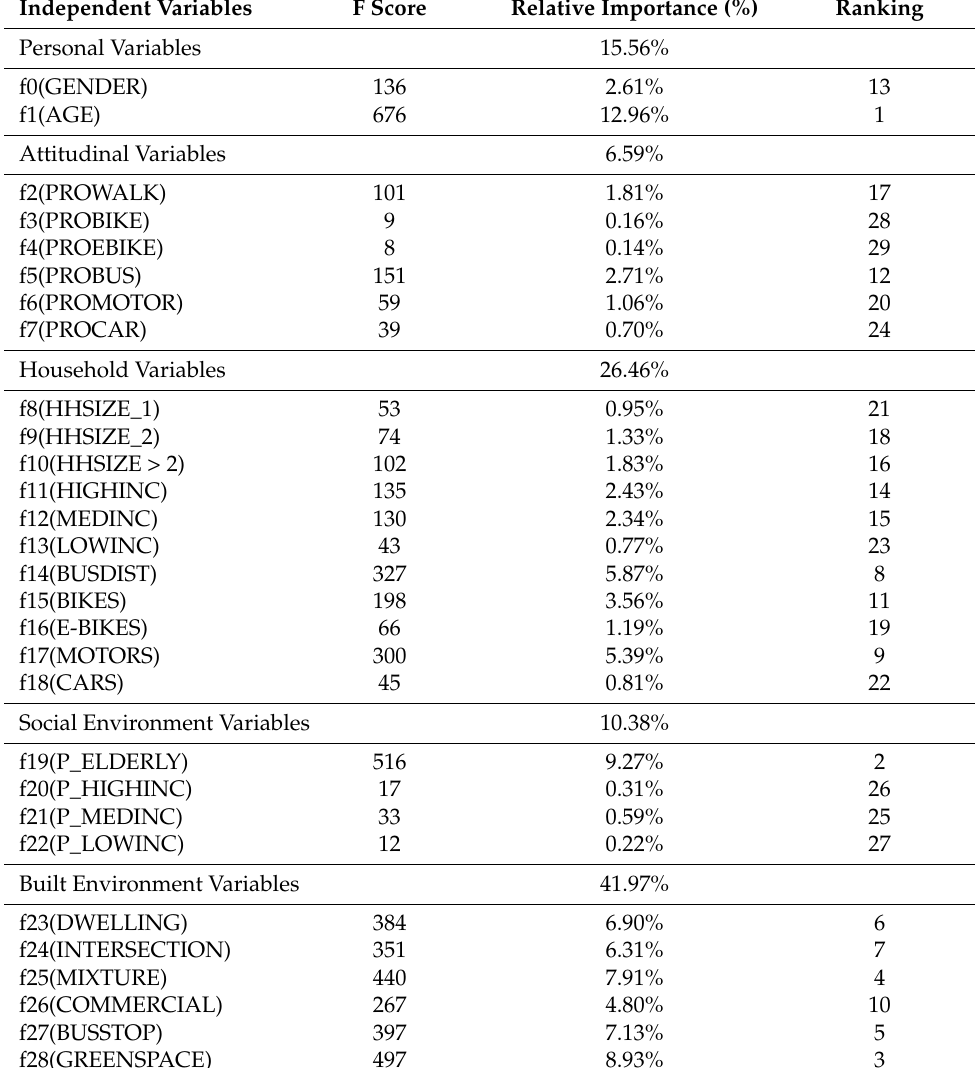
Table 4. Relative importance of independent variables in